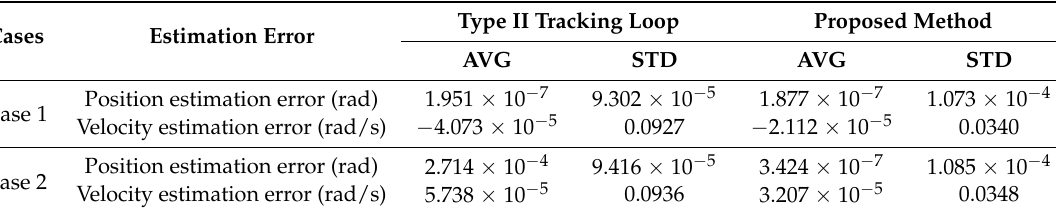
Table 2. Estimation error in simulation.